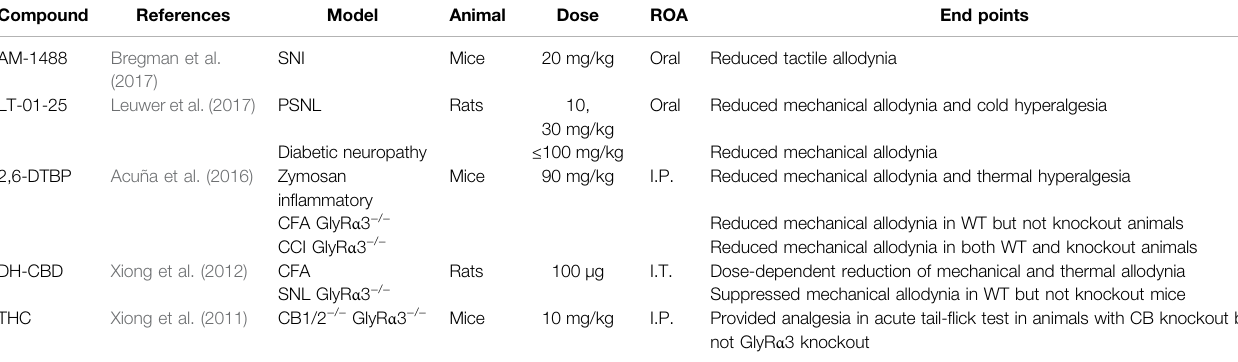
TABLE 3 | Experiments investigating known GlyR-positive allosteric